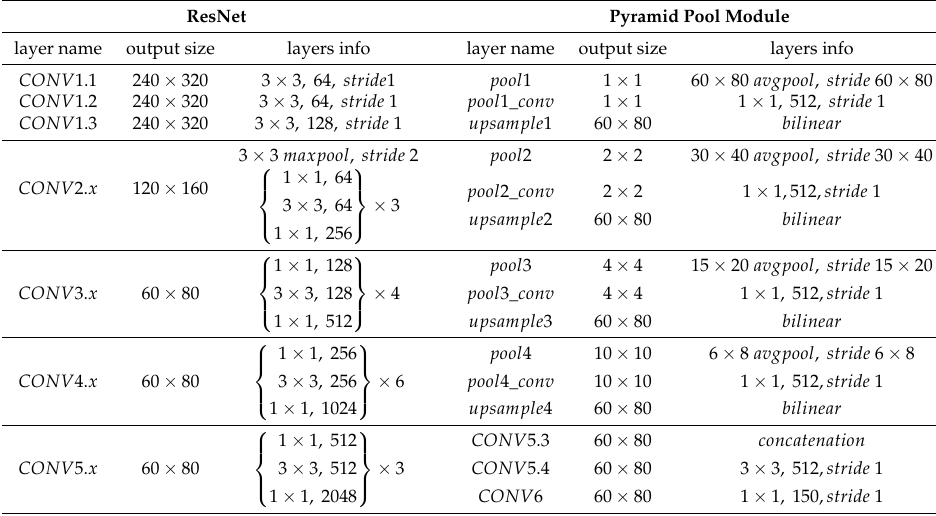
Table 1. The details of the architecture of the modified PSPNet.